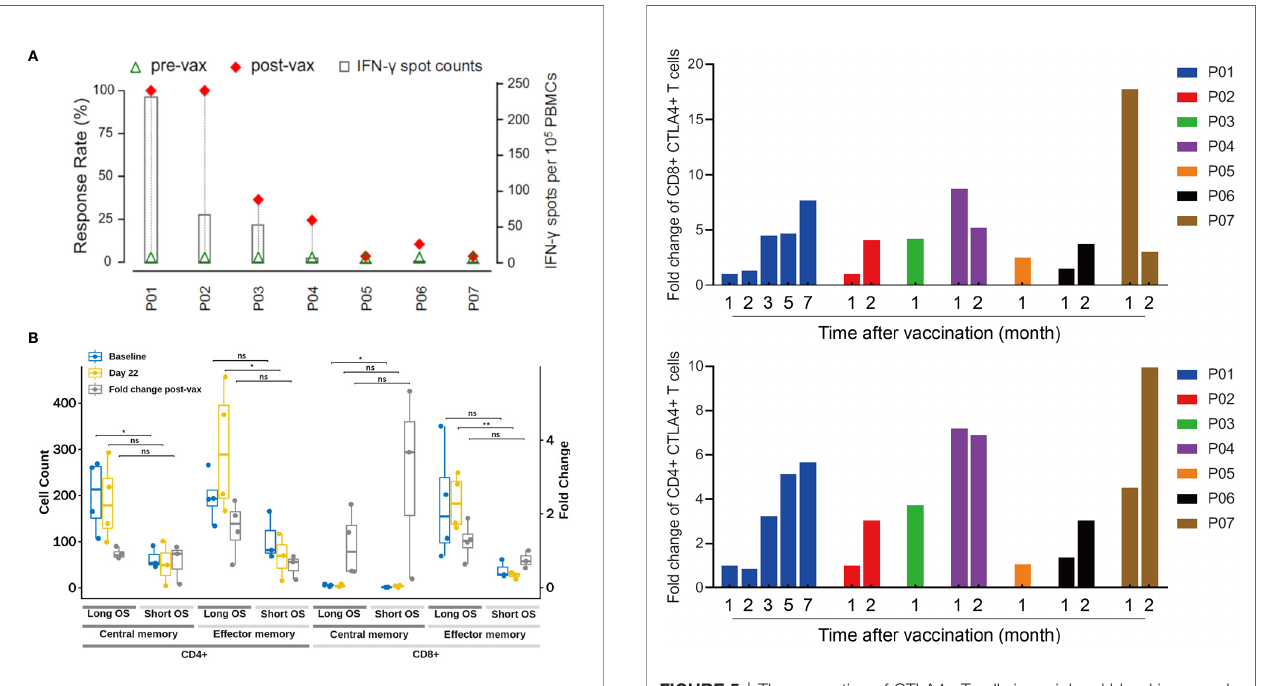
FIGURE 4 | Immune Response induced by iNeo-Vac-P01. (A) iNeo-Vac-P01 induced speci fi c T cell response. For each patient marked in X-axis, green triangle and red diamond represent the response rates pre- and post- vaccination, de fi ned as the ratios of the numbers of peptides (or peptide pools) with positive ELISpot results before and after vaccination to the total number of peptides (or peptide pools) in vaccine, respectively. The bar chart with secondary Y-axis represented the IFN- g spots per 10 5 PBMCs of the peptide with best response for each patient. (B) Change in T cell subsets count at baseline and 22 days post iNeo-Vac-P01 vaccination. Blue and yellow dots represent the cell counts at baseline and 22 days post iNeo-Vac- P01, respectively. Grey dots represent the fold change of corresponding cell count, which can be read at the right Y-axis. Counts of T cell subsets including CD4 + central memory, CD4 + effector memory, CD8 + central memory and CD8 + effector memory T cells were compared in long OS patients (shown in dark grey) and short OS patients (shown in light grey). *: signi fi cant, p=0.01 to 0.05; **: very signi fi cant, p=0.001 to 0.01; ns: not signi fi cant.